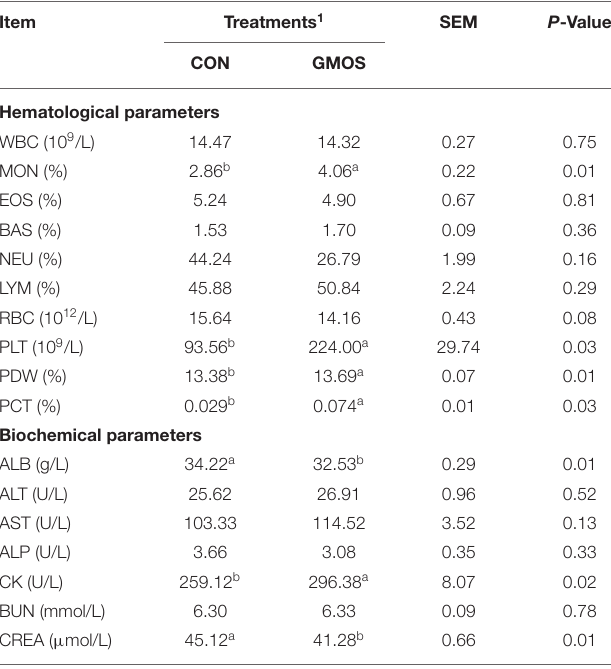
TABLE 6 | Effect of dietary supplementation of GMOS on hematological and serum biochemical parameters in goats. Item Treatments 1 SEM P -Value